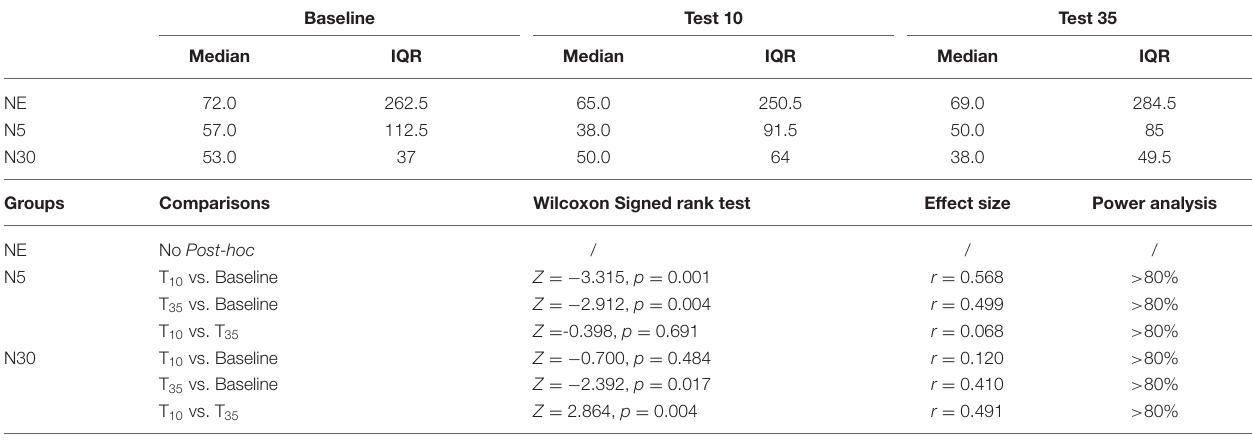
TABLE 2 | Median and interquartile range of CPT pain tolerance of all groups at the three test and within-group comparisons of CPT tolerance.